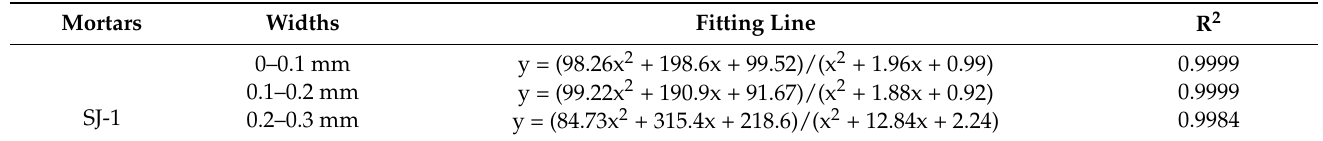
Figure 14. Surface cracks repairing ratios of mortars. ( a ) SJ-1, ( b ) SJ-2. Table 5. Self-repair equations for surface cracks of all widths.